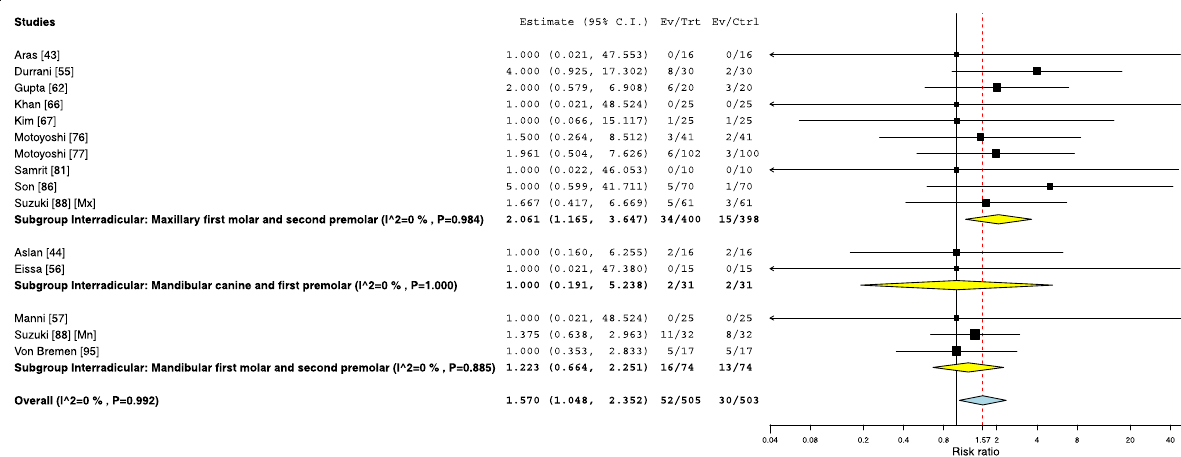
Fig. 8 Forest plot showing the risk ratio for failure when OMIs where placed in the right versus the left sides